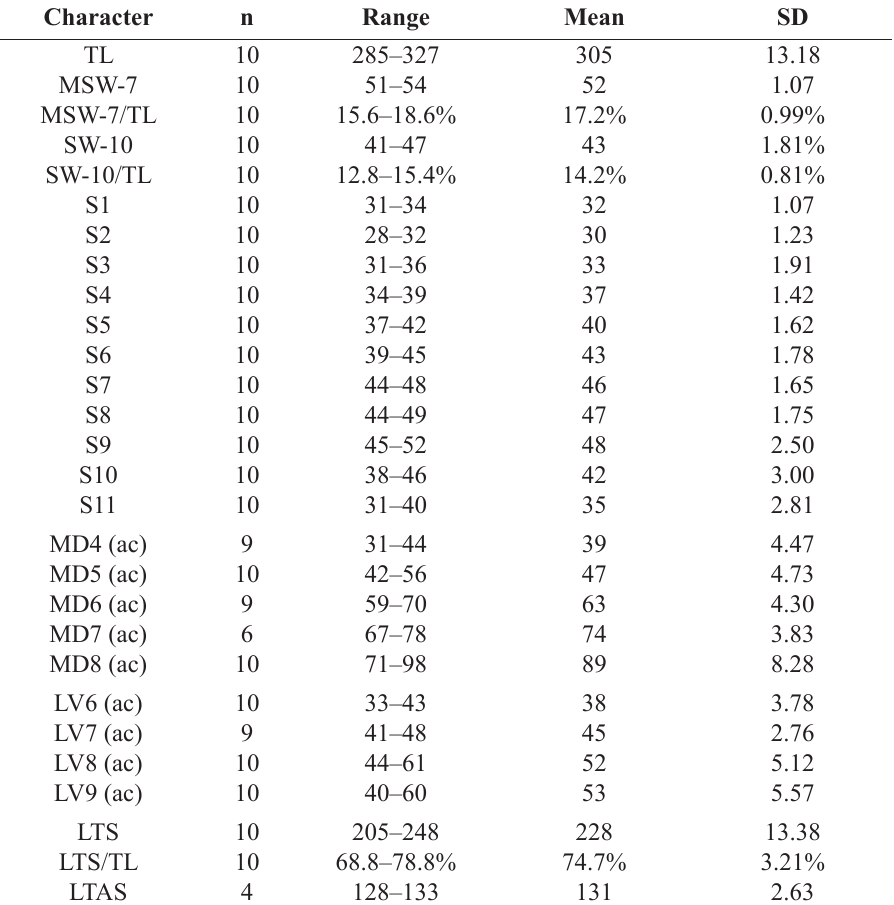
Table 10. Measurements from light microscopy of Echinoderes juliae sp. nov. (in µm), including number of measured specimens (n) and standard deviation (SD). Abbreviations: (ac) = acicular spine; LTAS = lateral terminal accessory spine; LTS = lateral terminal spine; LV = lateroventral; MD, middorsal; MSW-7 = maximum sternal width, measured on segment 7 in this species; S = segment lengths; SW- 10 = standard width, always measured on segment 10; TL = trunk